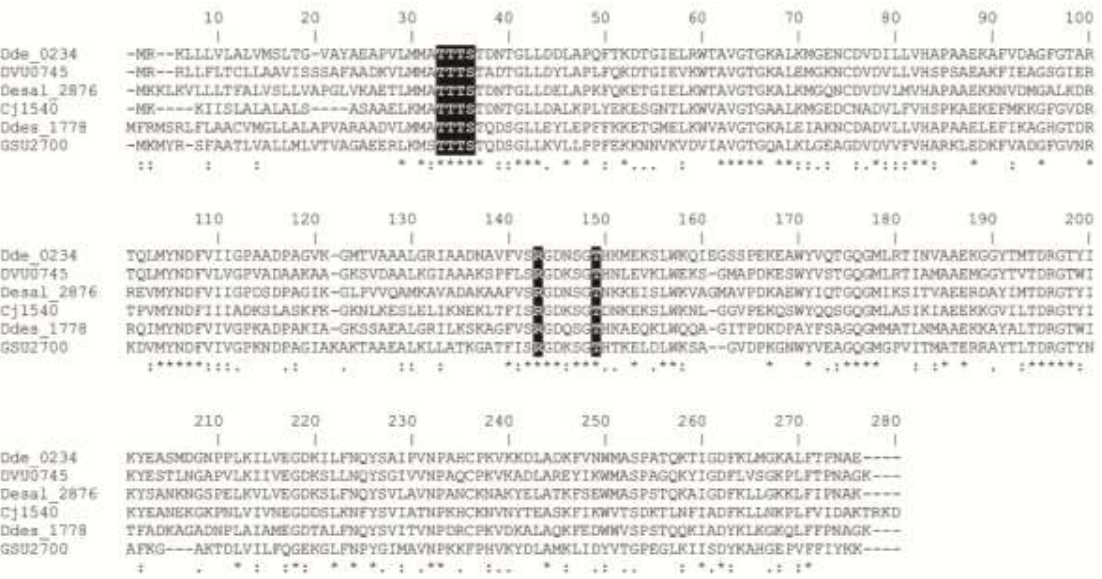
Figure 1. Multiple sequence alignment of TupA proteins performed with ClustalW [29]. Dde_0234, Desulfovibrio alaskensis G20; DVU0745, Desulfovibrio vulgaris Hildenborough; Dde_2876, Desulfovibrio salexigens ; Cj1540; Campylobacter jejuni strain NCTC 11168; Dde_1778, Desulfovibrio desulfuricans ATCC 27774; GSU2700, Geobacter sulfurreducens . Residues putatively involved in the coordination of tungstate are highlighted in black. Symbols: ( * ) identity, (:) strongly similar and (.) weakly